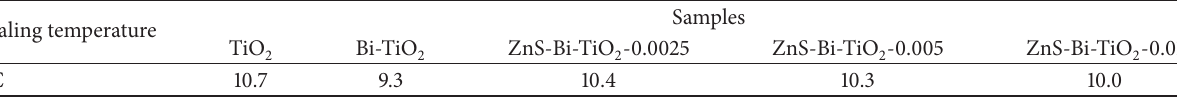
, Bi-TiO , and ZnS-Bi-TiO 2 2